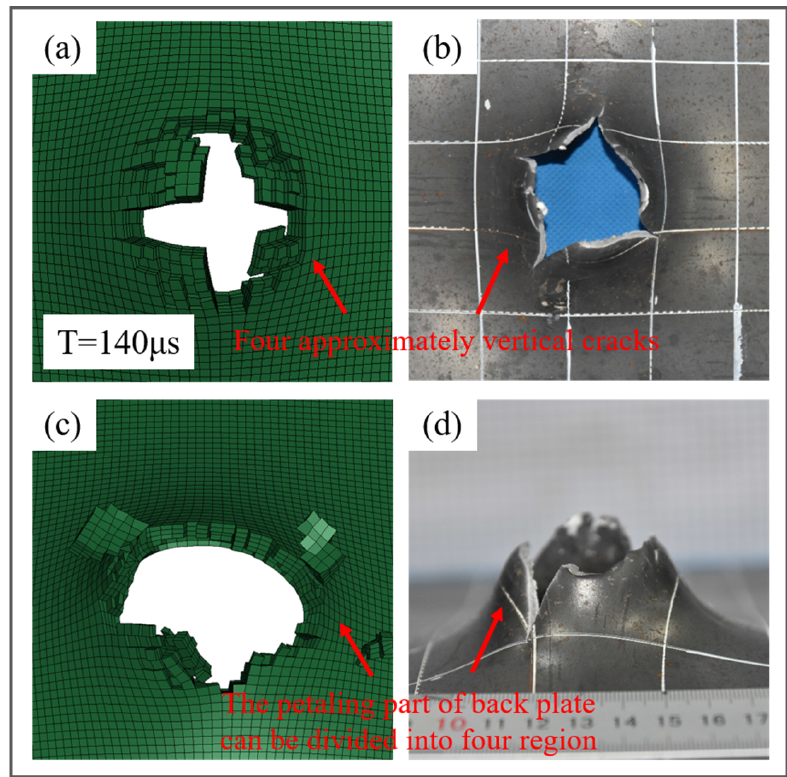
Figure 6. Comparison of back plate damage morphology of in Experiment 1.